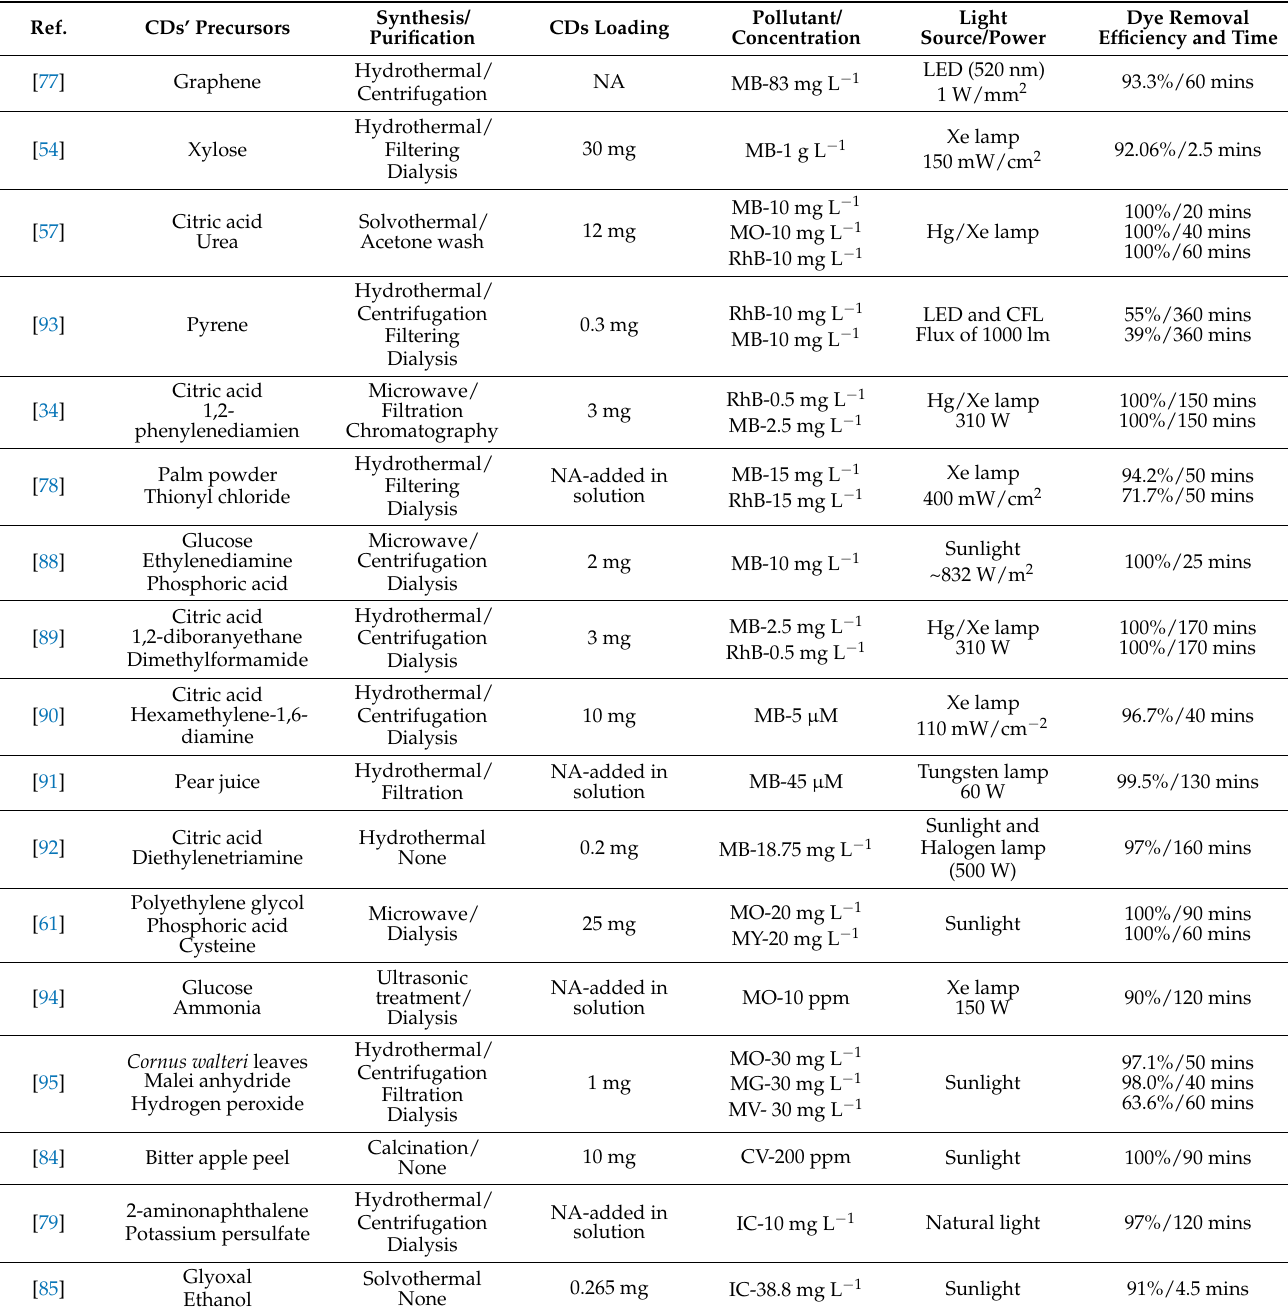
Table 1. Summary of studies concerning CDs’ mediation photodegradation of organic pollutants. NA—not available; CFL—compact fluorescent